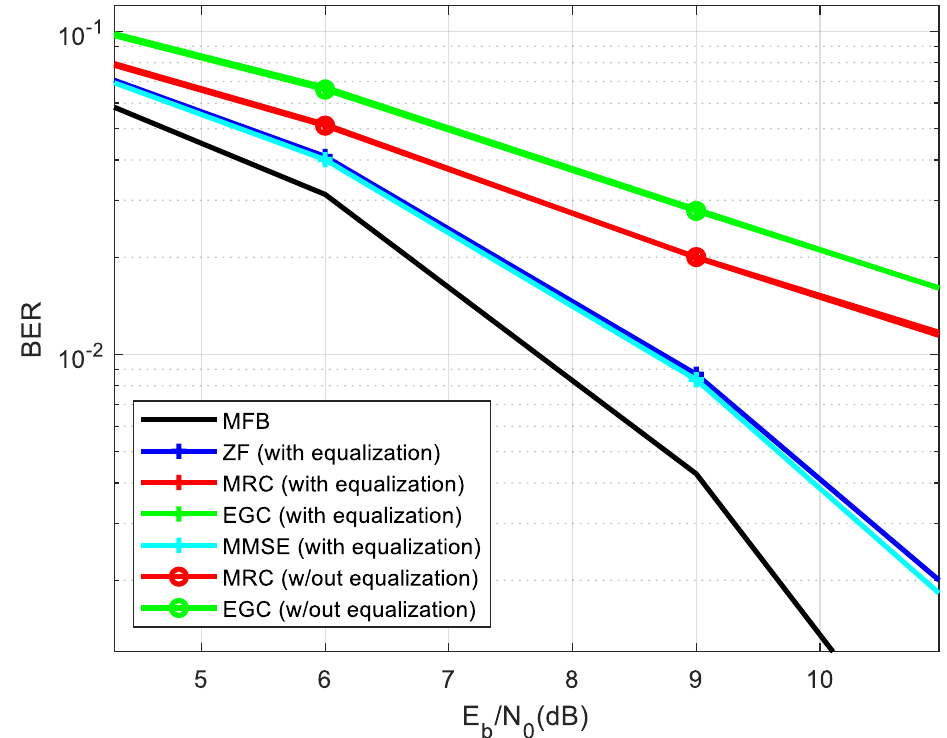
Figure 4. Results for 4X25 LIS System, with 5 users, without LDPC codes, with and without equalization.